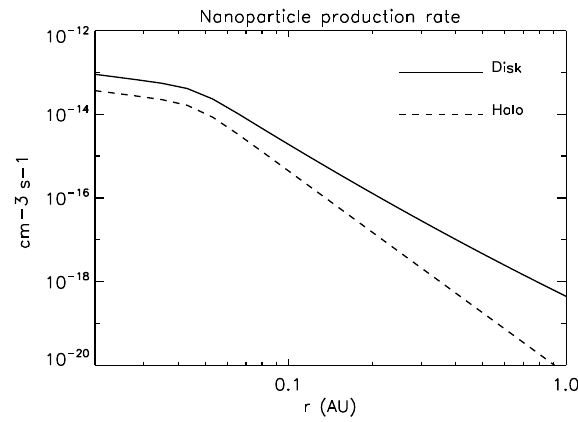
Figure 3. Nanodust creation rate as a function of the heliocen- tric distance assumed in our calculations (Czechowski and Mann,